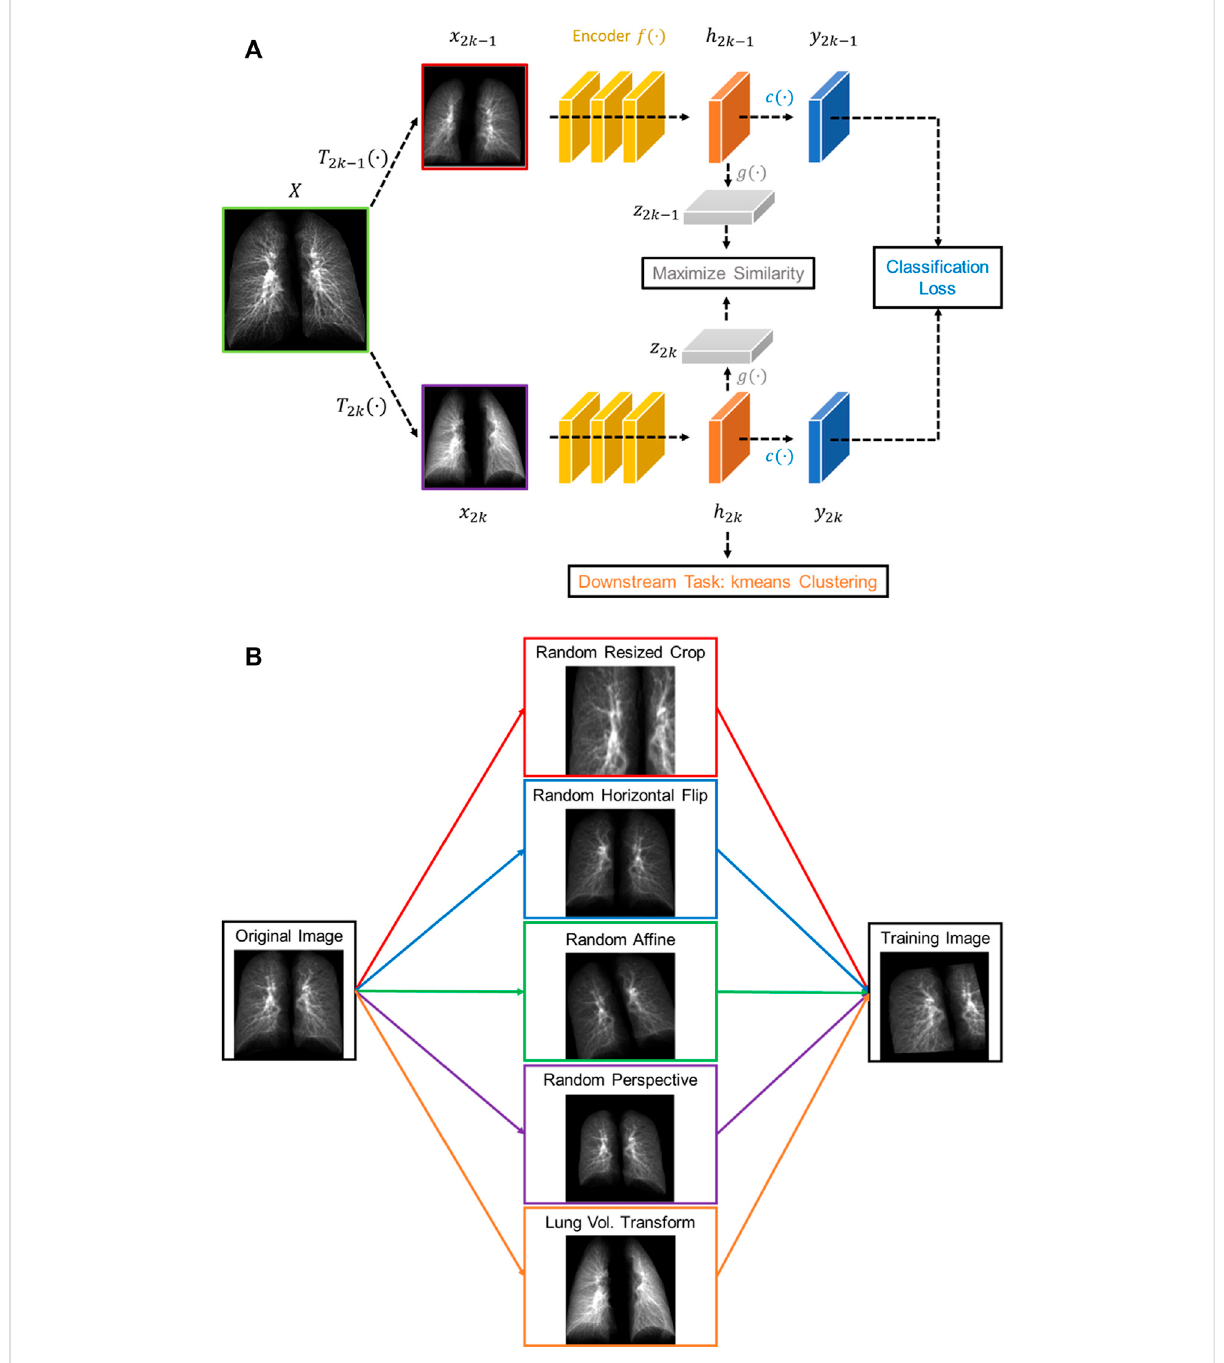
FIGURE 1 (A) The structure of the proposed volume-independent contrastive learning model. (B) Illustrations of the transforms applied to the training